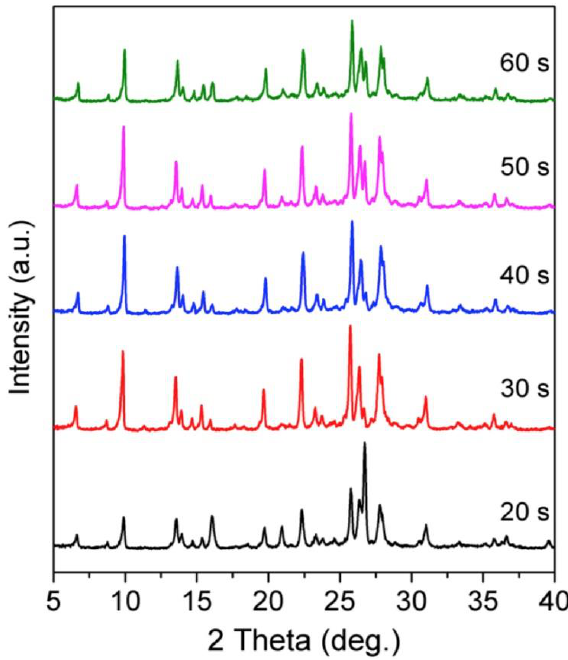
Figure 2. pXRD of as-made SSZ-13 products obtained from mixtures prepared with precipitated silica with an application of milling for various times: 0—only preliminary manual grinding, 1, 5, 10, 20 min of milling. (Reprinted with permission from [46]. Copyright: 2019, John Wiley and sons.).